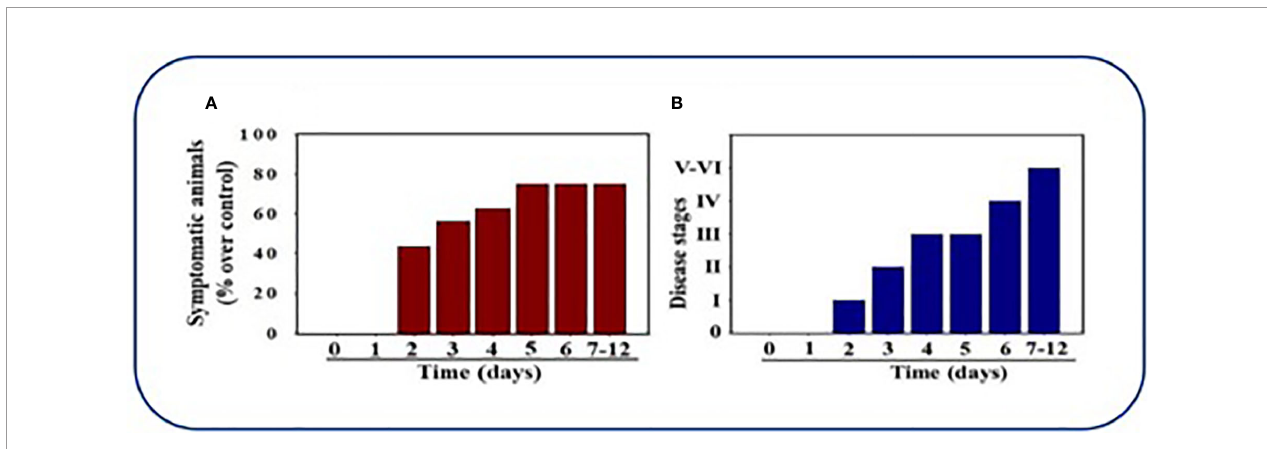
FIGURE 5 | Mice infected by MHV-1 inoculation. (A) 40% of mice were symptomatic by Day 2 post-infection and exhibition of clinical signs progressively increased to 75%. (B) Mice inoculated by MHV-1 exhibited clinical signs starting at 2 days post-infection. Mild to moderate stage (I-III) of clinical symptoms were seen on days 2-4. Severe sickness (IV-VI) was seen in mice after 6 days. Reproduced with permission from Paidas et al, Viruses; Published by MDPI,